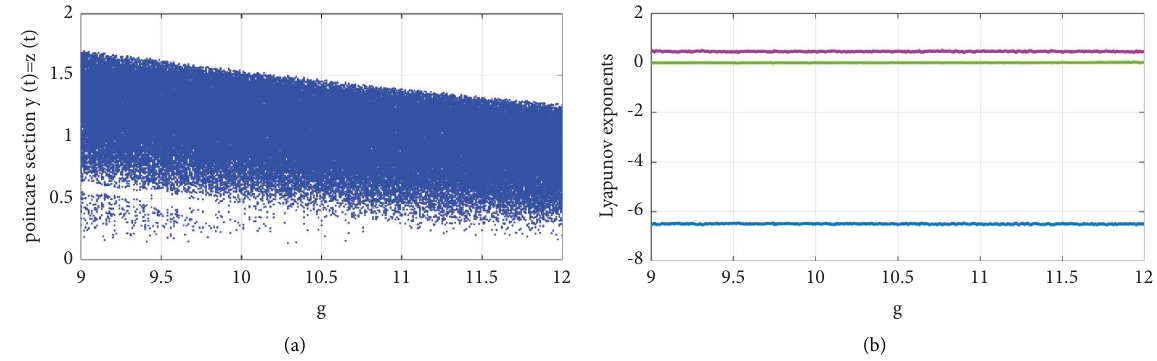
Figure 9: (a) Te system bifurcation diagram and (b) the corresponding Lyapunov exponents, utilizing g as the bifurcation parameter with fxing the other parameters constant such that a � 2 ,b � 7 , c � 5 , f � 8 , and r �